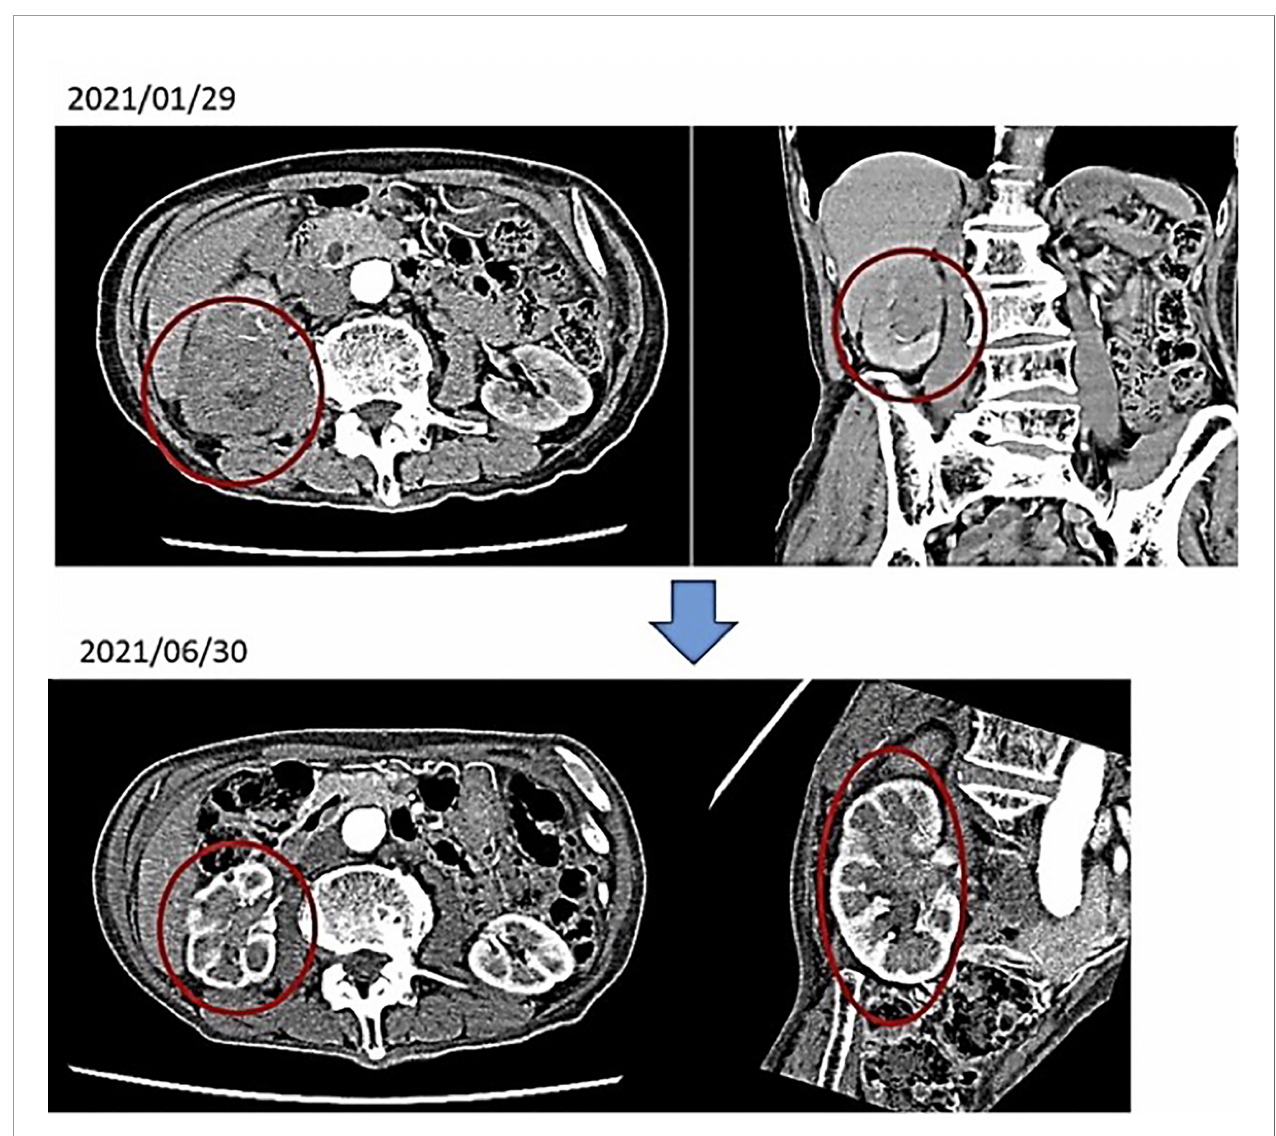
FIGURE 2 | A contrast enhanced computed tomography of abdomen are